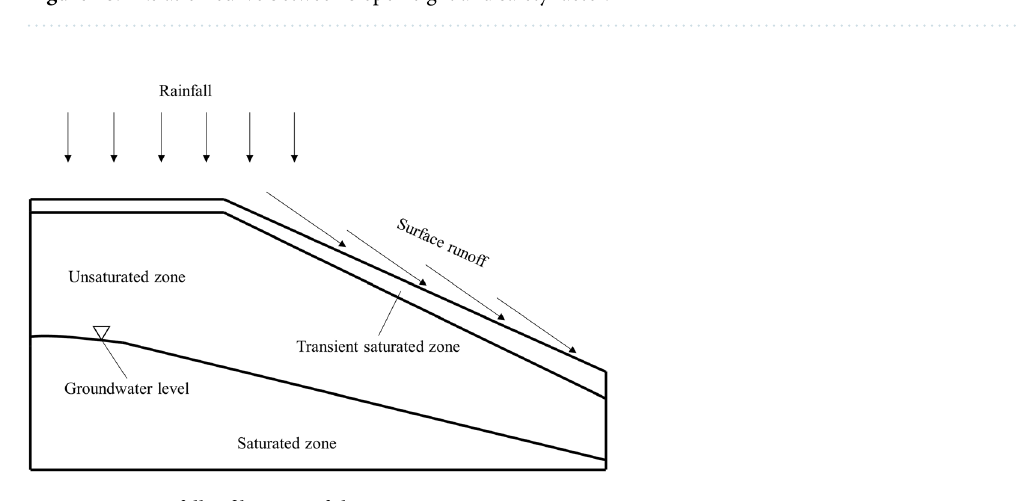
Figure 11. Rainfall infiltration of